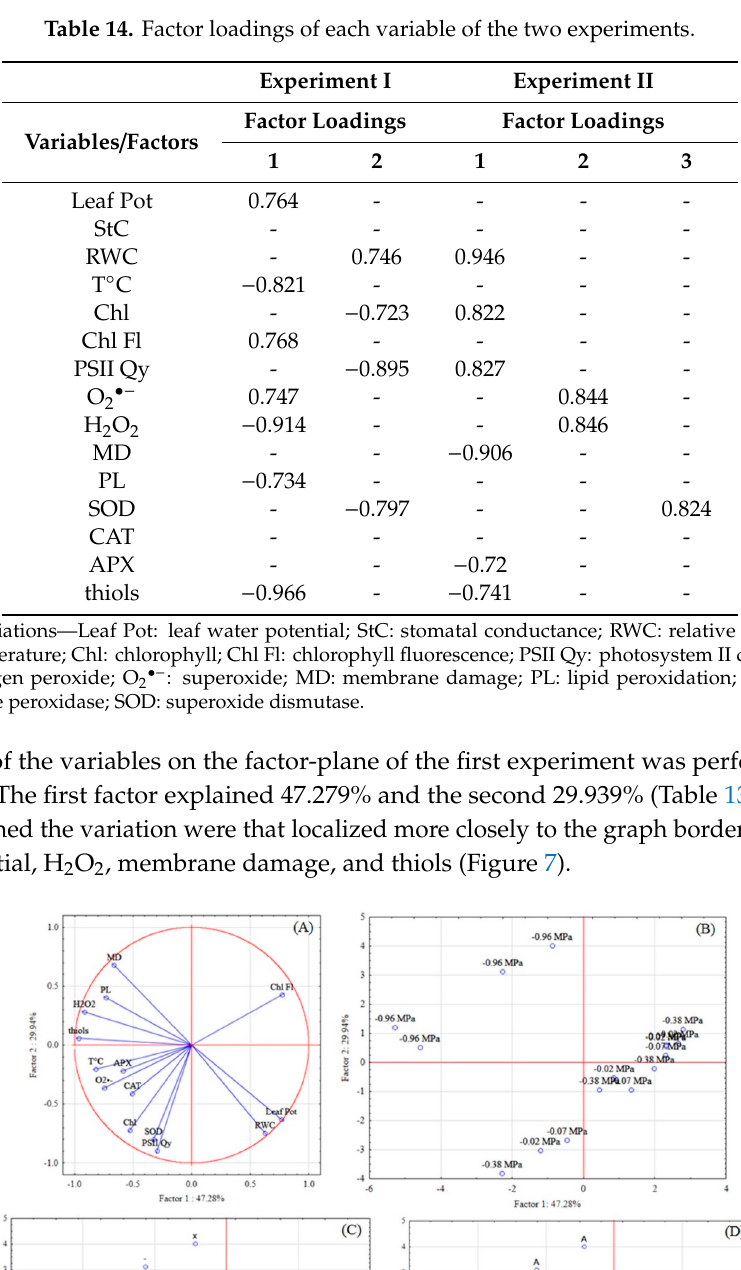
Table 14. Factor loadings of each variable of the two experiments.